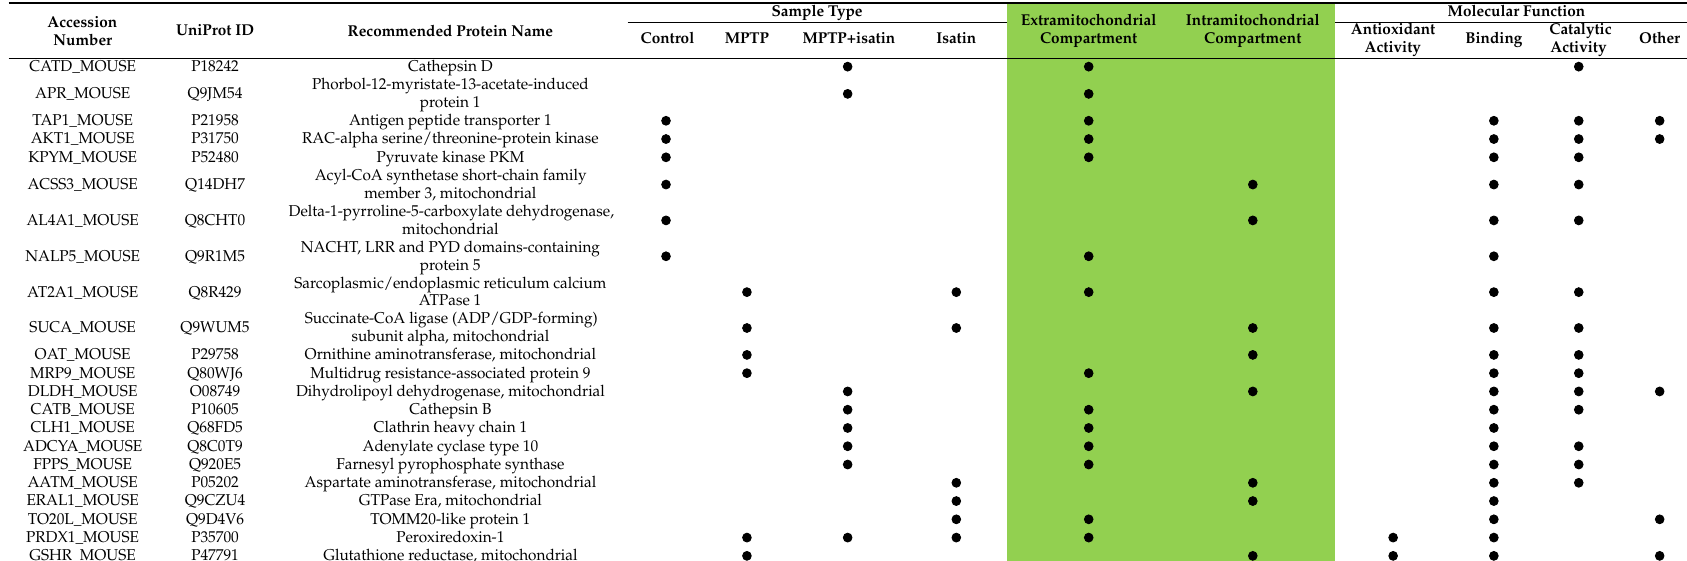
Table 1. Functional annotation of ubiquitinated proteins of mouse brain mitochondria in GO